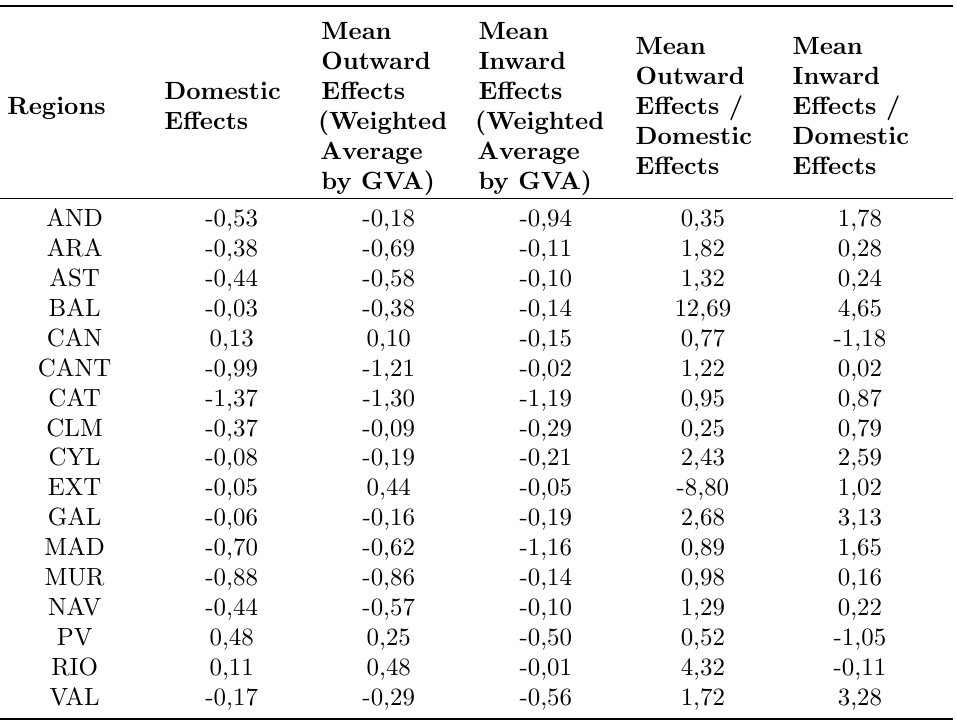
Table 4: Regional Effects after 5